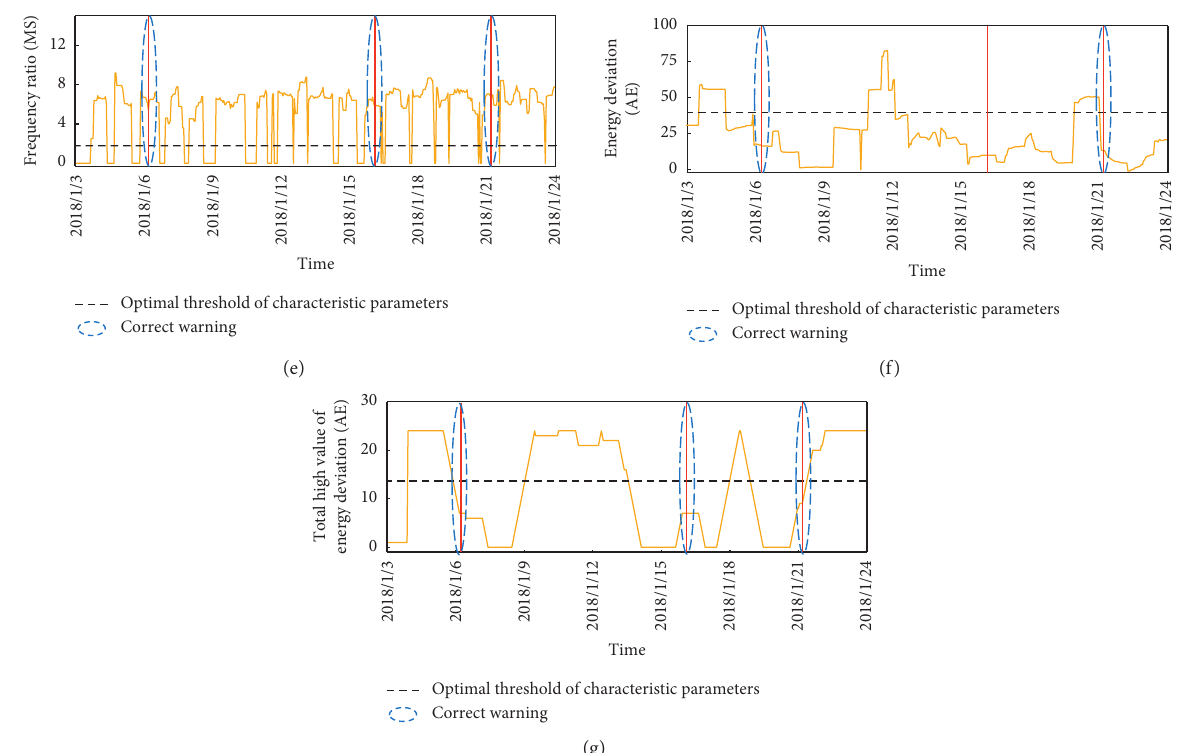
Figure 12: Time series curve of precursory characteristic parameters of each system in January 2018, (a) energy of MS event; (b) time series curve of D E of MS system; (c) time series curve of D F of MS system; (d) time series curve of D S of MS system; (e) time series curve of F r of MS system; (f) time series curve of D E of AE system; (g) time series curve of D H of AE system ① 2018/1/6 04: 30:48, 1.9 E +05J; 2018/1/6 04: 30: 31, 9.8 E +05J; ② 2018/1/16 01 :25: 45, 4.50 E +05J; ③ 2018/1/21 04 :07: 24, 6.6 E +06 J.